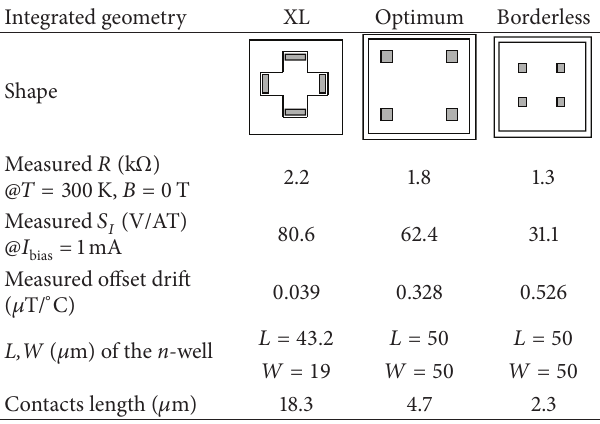
Table 1: Specific parameters evaluation for some of the integrated Hall cells.